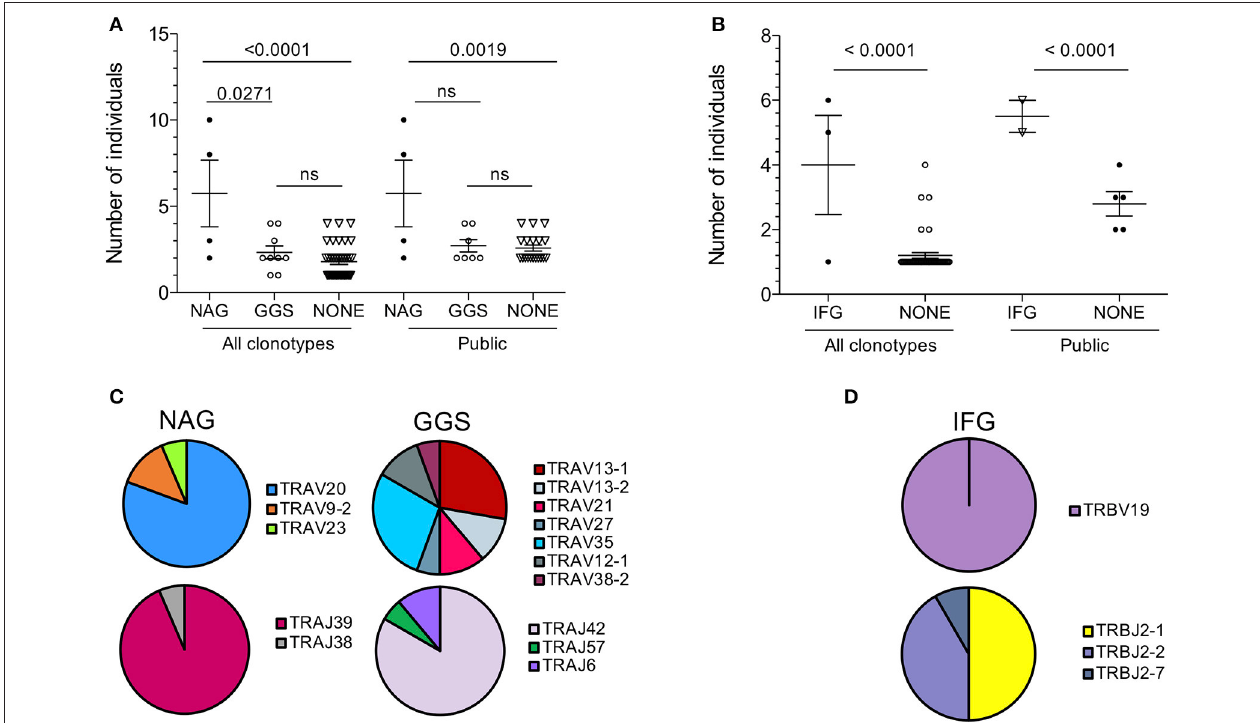
FIGURE 5 | Amino acid motif conservation in public clonotypes from HLA-B*44:03/NW8-specific CD8 + T cells. (A) The number of individuals sharing NAG or GGS-containing TCR- α chains is shown. (B) The number of individuals sharing IFG-containing TCR- β chains is shown. (C) TRAV and TRAJ gene usage in NAG or GGS-containing TCR- α chains is illustrated as pie charts. Frequencies are calculated as fraction of NAG or GGS- containing amino acid sequences. (D) TRBV and TRBJ gene usage in IFG-containing TCR- β chains is illustrated as pie charts. Frequencies are calculated as fraction of IFG-containing amino acid sequences. Horizontal bars represent the mean and standard of the mean. Statistical significance is shown where p < 0.05 (ns = not significant). Pie charts illustrate the frequency of a V or J gene. Colours are assigned randomly and do not correspond to a fixed a